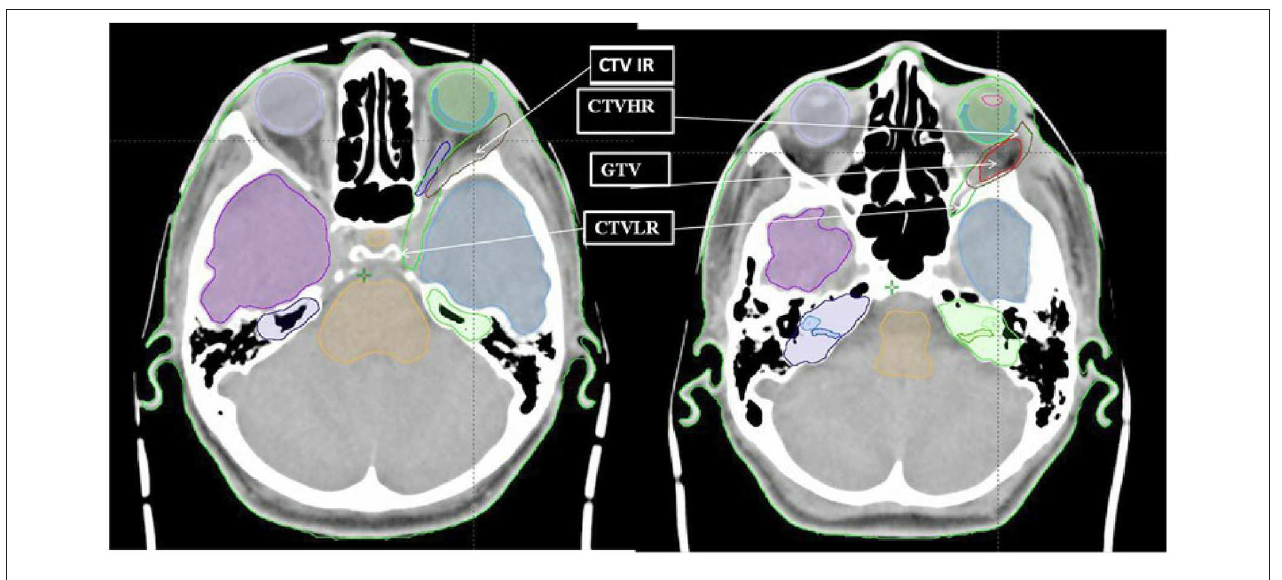
FIGURE 1 | Delineation of HR, IR and LR clinical target volumes. superior oblique fields has been adapted to the different volumes. The dose constraints to the critical organs are summarized in Supplementary Table 1 . Coverage of 95% of the target volume by 95% of the prescribed dose was expected.